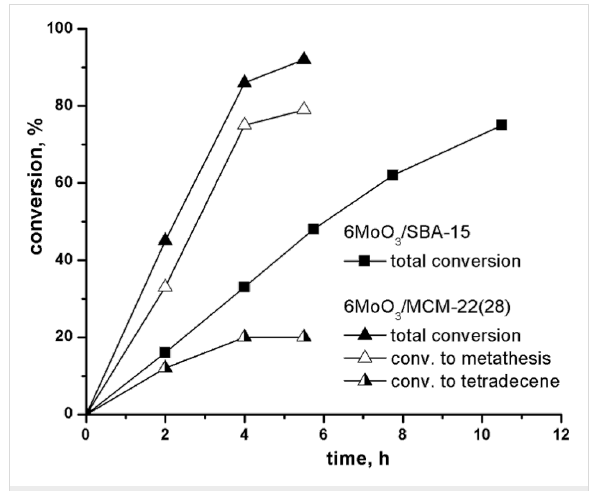
Figure 2: Conversion vs time curves for 1-octene metathesis over 6MoO 3 /MCM-22(28) and 6MoO 3 /SBA-15. Neat 1-octene, 1-octene/Mo = 320, t = 40